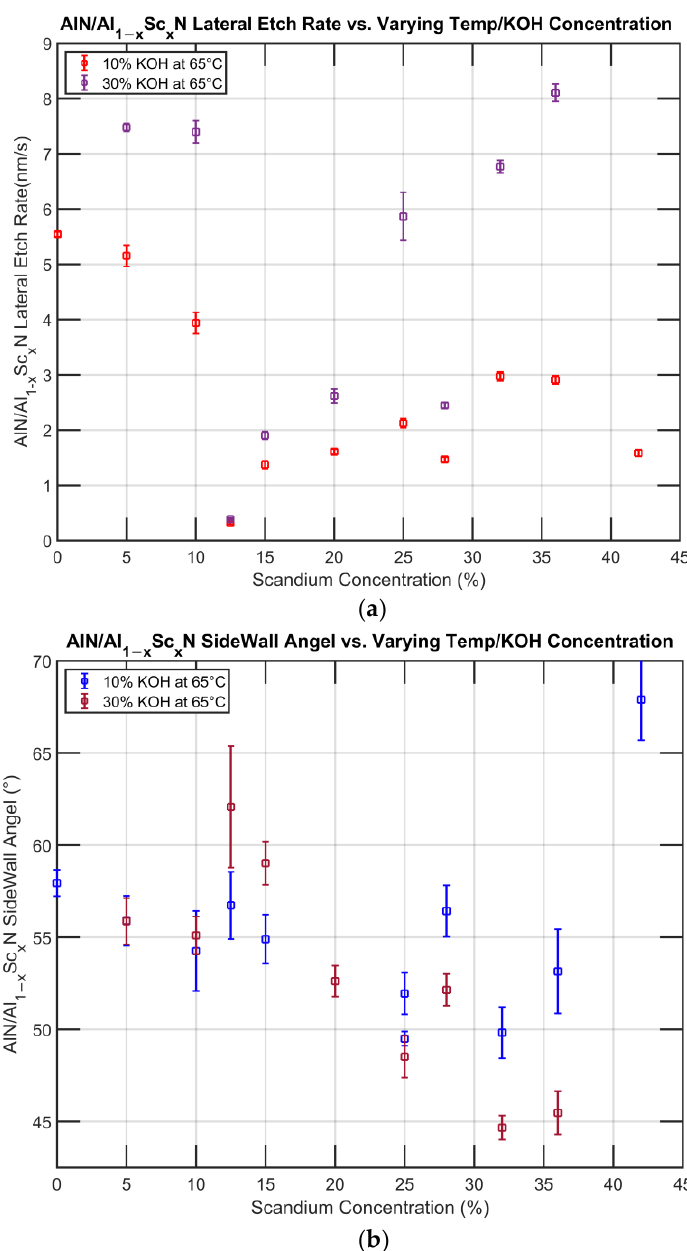
Figure 11. ( a ) Lateral etch rate at elevated temperature and lower etchant concentration. ( b ) Sidewall angle at elevated temperature and lower etchant concentration.